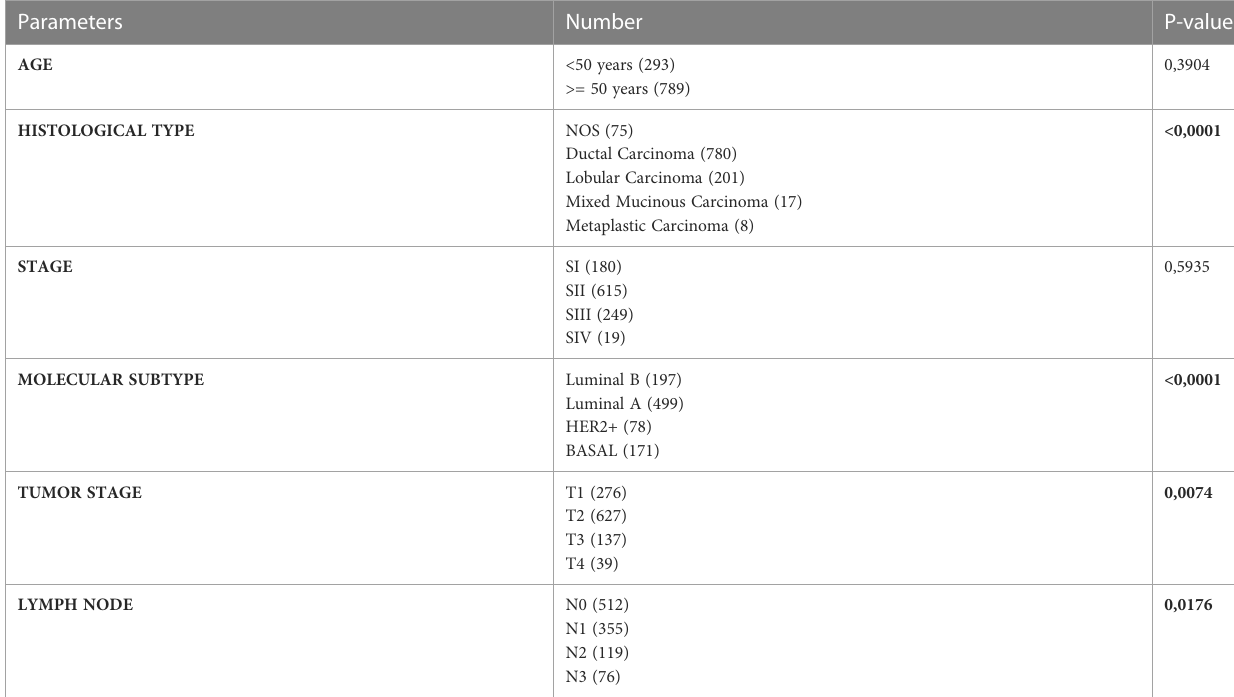
TABLE 1 VISTA expression according to different clinicopathological parameters on TCGA cohort.